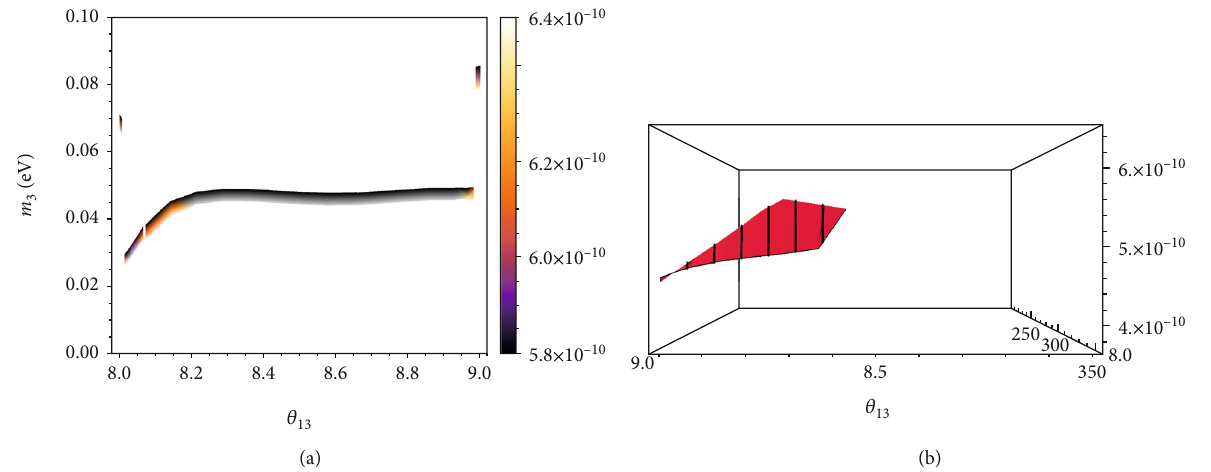
Figure 16: Predictions in the broken μ − τ symmetry model for inverted ordering. (a) The density plot of predicted favoured values of the ð m Þ plane for the best fi t values of δ , θ = 285 ° of Δχ 2 = 6 : 2 w/o SK-ATM [14] (allowed by updated values of correct baryon 3 13 CP asymmetry of the Universe) as a result of contribution of the type I seesaw mechanism to neutrino mass matrix. Similarly, (b) shows the three-dimensional plot for predicted favoured values of the ð θ , δ , η Þ plane for the lightest ν mass, m = 0 : 0657 (in the light of recent 13 CP 3 ratio of the baryon to photon density bounds, 5 : 8 × 10 − 10 < η < 6 : 6 × 10 − 10 ) as a result of contribution of the type I seesaw mechanism to neutrino mass